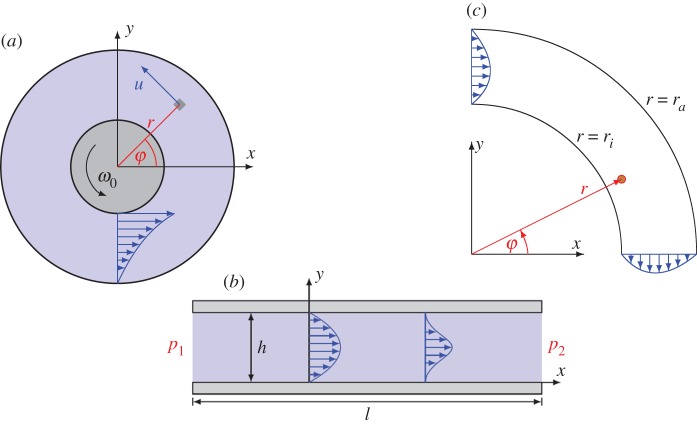
Flow geometry of the three flows: (a) Taylor–Couette flow, (b) plane Poiseuille flow and (c) Poiseuille flow in a curved channel. The velocity profiles resulting from the equations of motion are included.